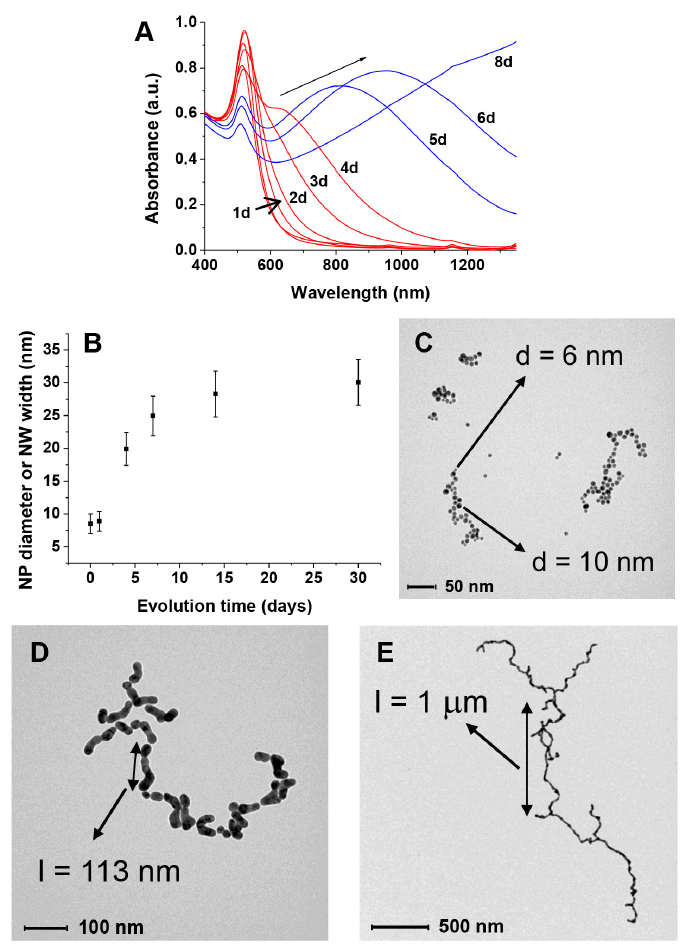
Figure 3. Behavior of citrate-depleted AuNPs in the presence of GAP: ( A ) evolution of the UV–Vis spectrum with time. In red, necklace formation, in blue, nanoparticle fusion; ( B ) increase in size of the AuNPs or nanowires width with time; (B–D) TEM spectra taken at increasing times ( C ) 1day; ( D ) 4 days; ( E ) 8 days).